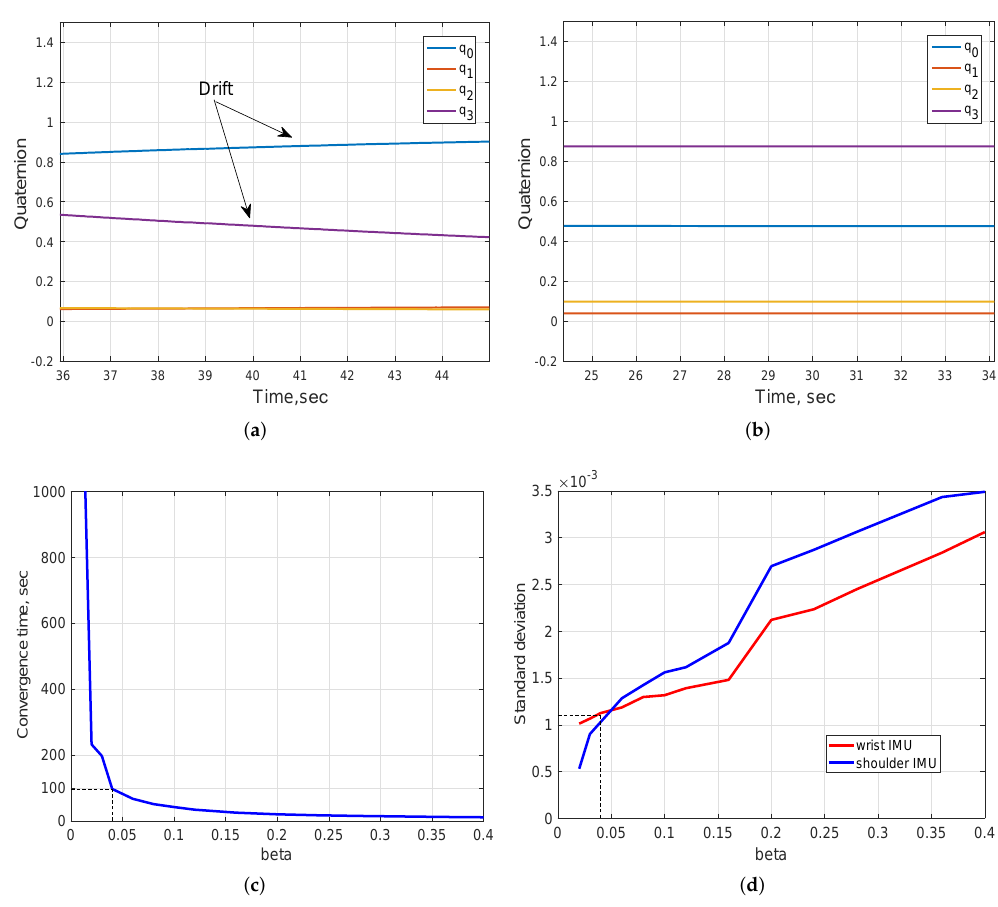
Figure 10. Tuning of data processing algorithms: UM7-LT’s built-in EKF processed quaternion outputs with ( a ) and without ( b ) drift; convergence time ( c ) and standard deviation ( d ) vs. beta gain of GDF